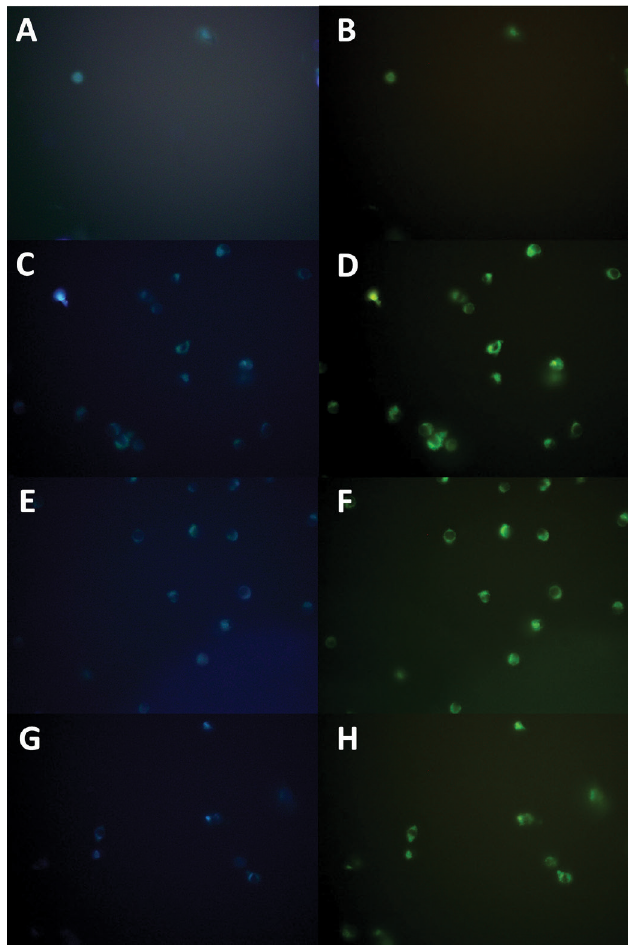
FIGURE 7 - Transfection ability of formulations (A and B: ME:DNA 5 µL, C and D: SLN :DNA 3 µL, E and F: EQ1 SLN :DNA 5 µL, G and H: Control (naked DNA+L929 cells)). EQ1 A,C,E,G images represent DAPI staining; B,D,F,H images represent fluorescence visualization.